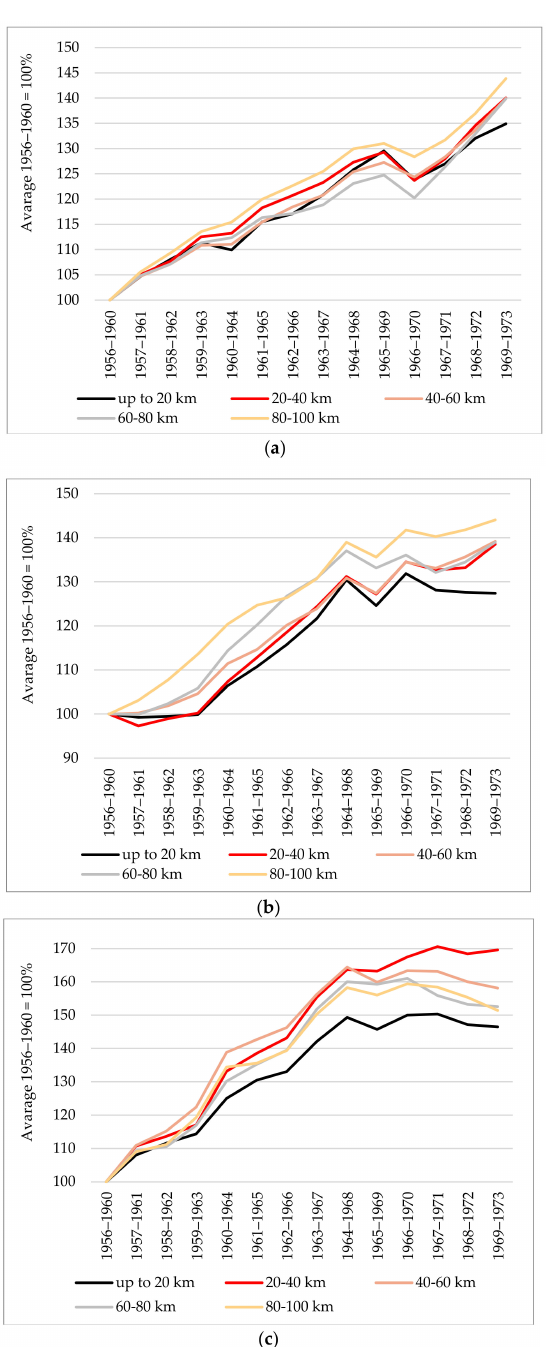
Figure 3. Yield level dynamics of selected crops depending on the distance from the open–cast mines (according to the data from the analyzed districts): ( a ) cereal; ( b ) potato; ( c ) sugar beet. Source: Based on